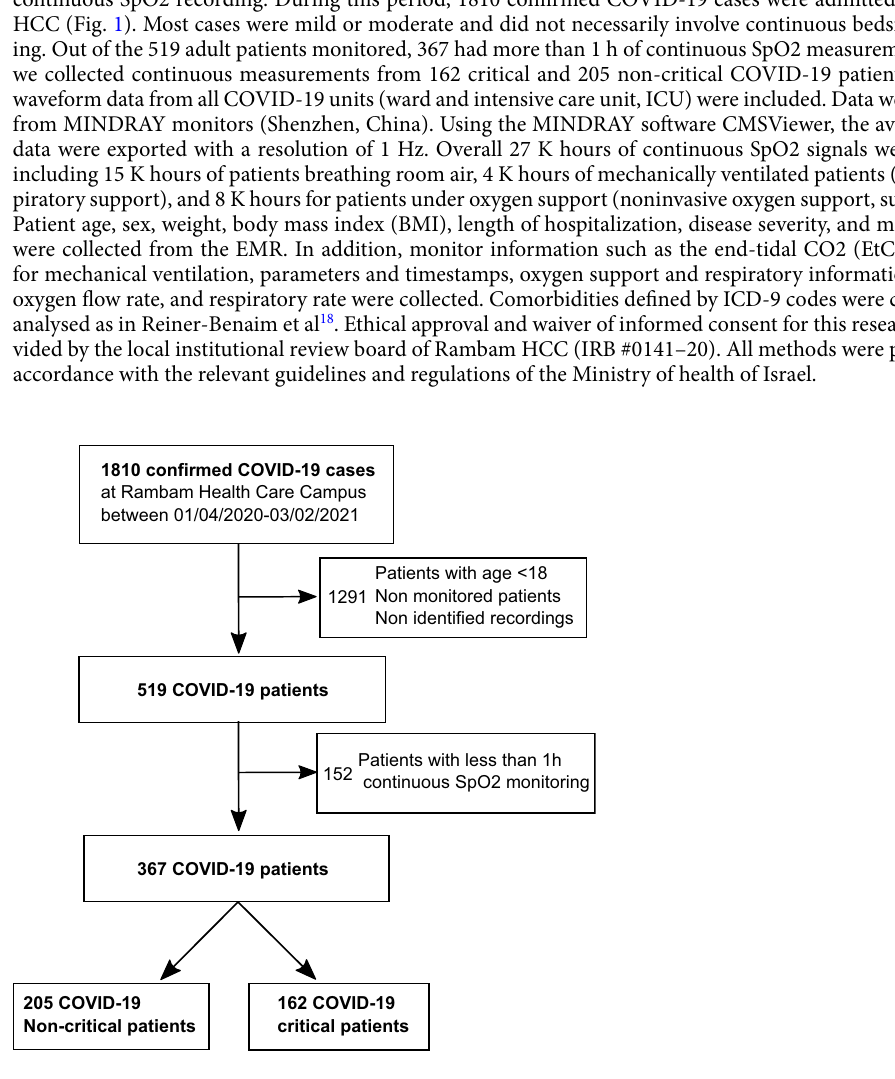
Figure 1. Block diagram showing the patient inclusion and exclusion criteria and groups